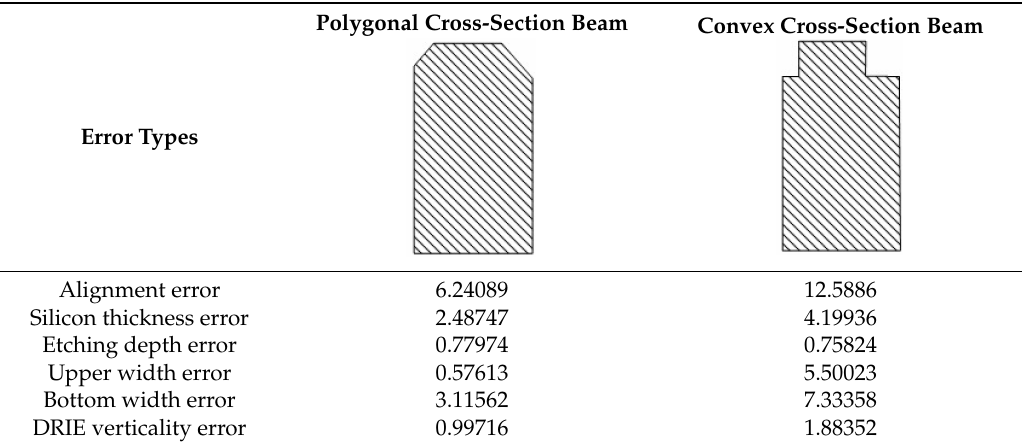
Table 3. The range of spindle azimuth angles under different fabrication imperfections (unit: